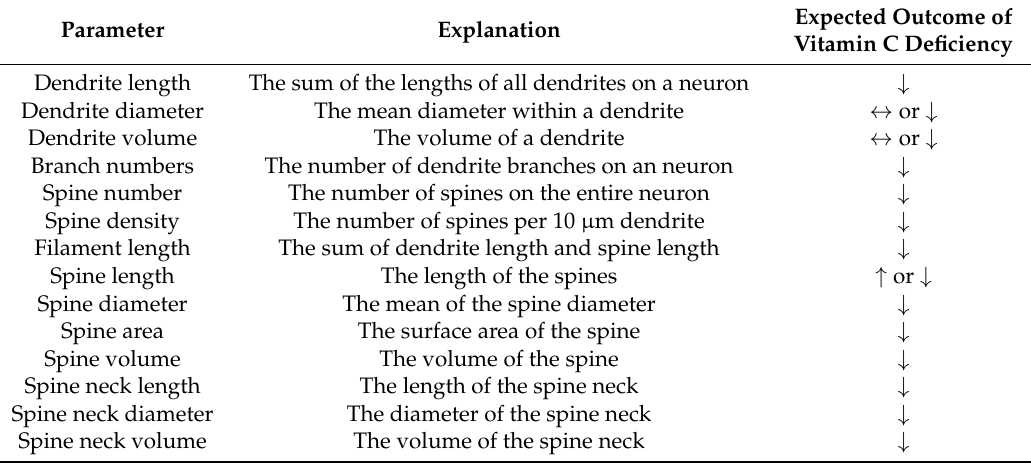
Table 1. Parameters included in the morphological analysis of cornu ammonis 1 pyramidal neurons. Vitamin C deficiency was expected to cause aberrant neuron morphology either directly or through subsequent oxidative stress thereby decreasing dendrite branching and length of cornu ammonis 1 pyramidal neurons causing an overall decrease in filament length. Furthermore, deficiency induced spine degeneration was expected to reduce total spine numbers and spine density, while also affecting the morphology of the spines. The change in spine morphology inflicted by deficiency was hypothesized to cause a shift towards a more immature/degenerated state of the dendritic spines with decreases in volume, area, diameter and shortening of the neck. Spine length could be increased due to an increase of immature filopodia or decreased due to degeneration [54,55]. The descriptions of the morphological parameters are based on descriptions in the Imaris manual provided by